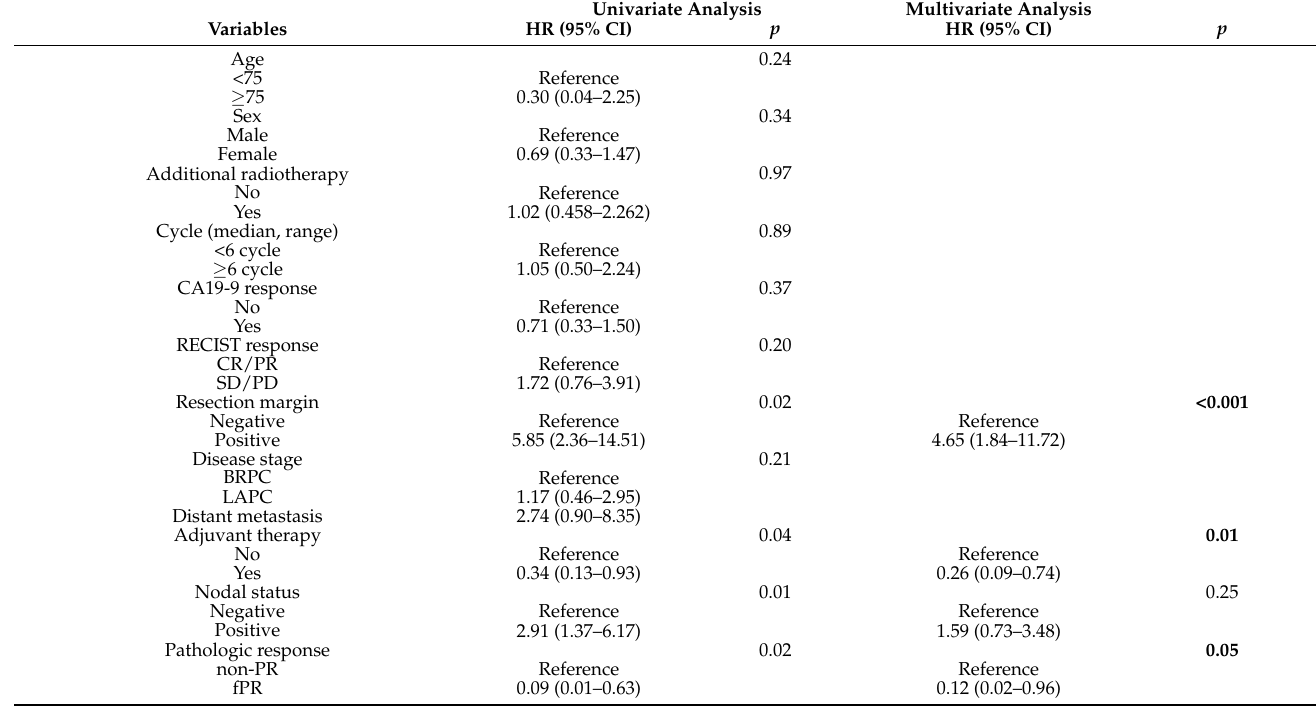
Table 2. Analysis for the association between overall survival and clinical